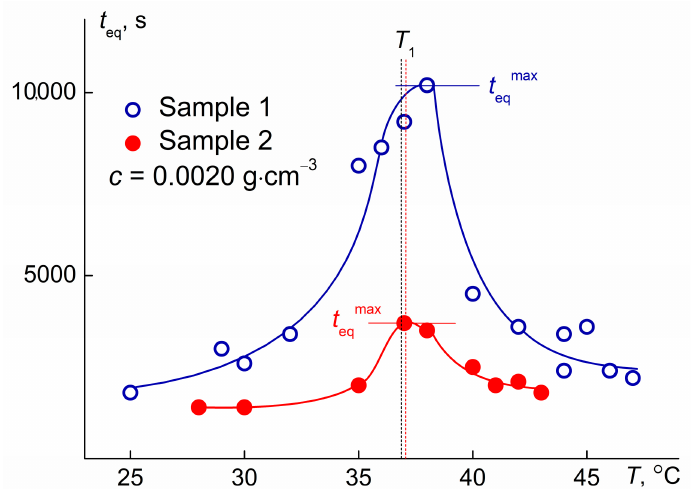
Figure 10. Temperature dependence of t eq for solutions of investigated samples. For both samples of PDMS- g -PiPrOx at low temperatures, t eq was in the range from 1500 to 3000 s. The same values of t eq were obtained at T → T 2 . The maximum “settling” times t eq(max) exceeded 10,000 s for Sample 1 and 6000 s for Sample 2. The t eq and t eq(max) values obtained for the investigated molecular brushes are greater than the typical “set- tling” times for linear thermosensitive polymers [26,80,81]. For other molecular brushes, the t eq(max) values of similar order of magnitude were obtained: for APE- g -PAlOx, the time t eq (max) reached 11,000 s [31,63], for grafted copolymer of chitosan and poly(N,